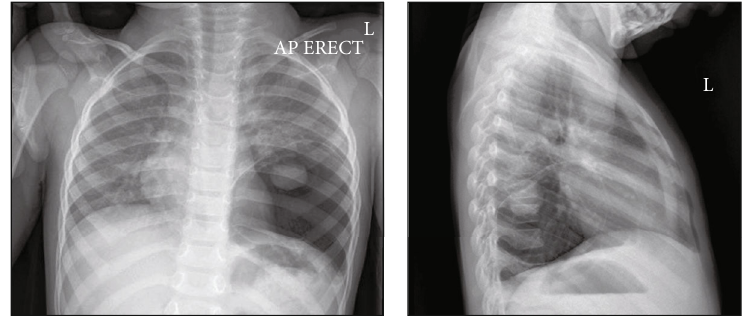
Figure 1: Anteroposterior and lateral chest X-ray showing cystic lesion at left lower zone.